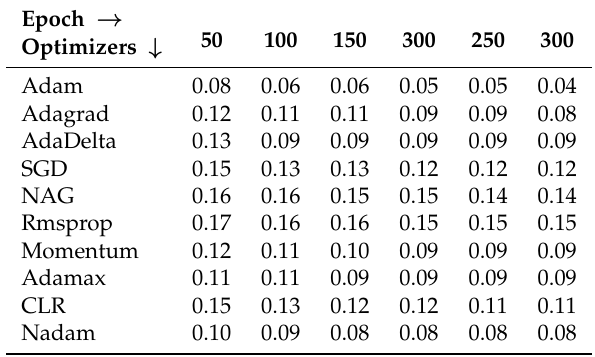
Table 8. Training loss of ten optimizers on a proposed patch-wise model architecture of CNN.